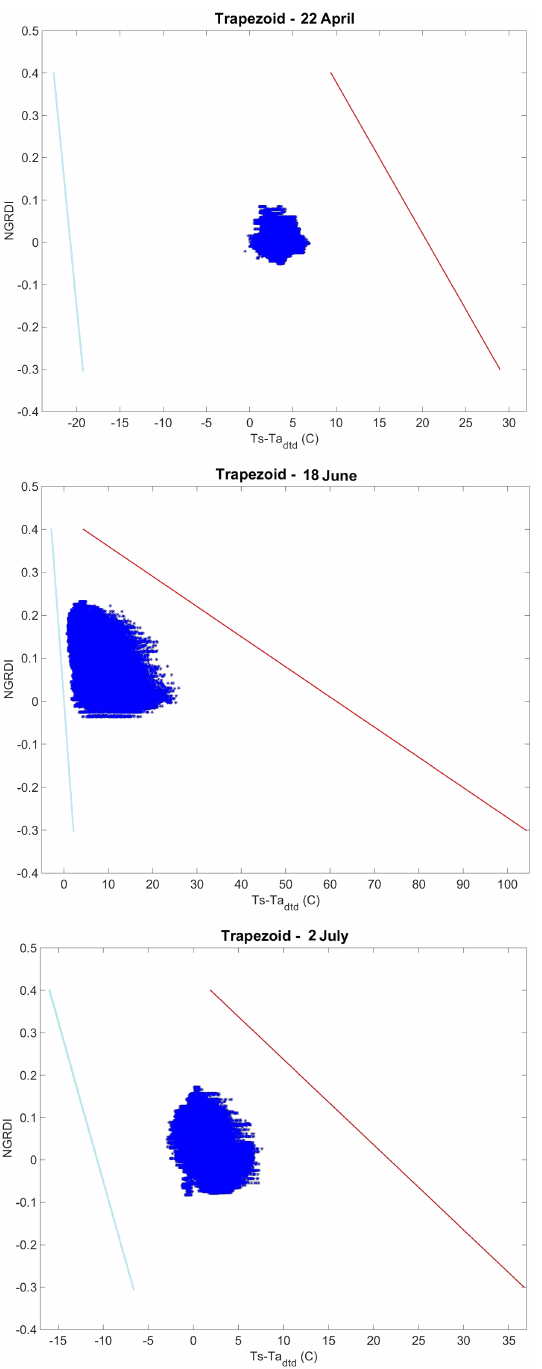
Figure A1. Computed trapezoids for the 3 data collection days. Red line is ( T S − T A ) max , light blue line is ( T S − T A ) min and dark blue dots are ( T S − T A ) mes